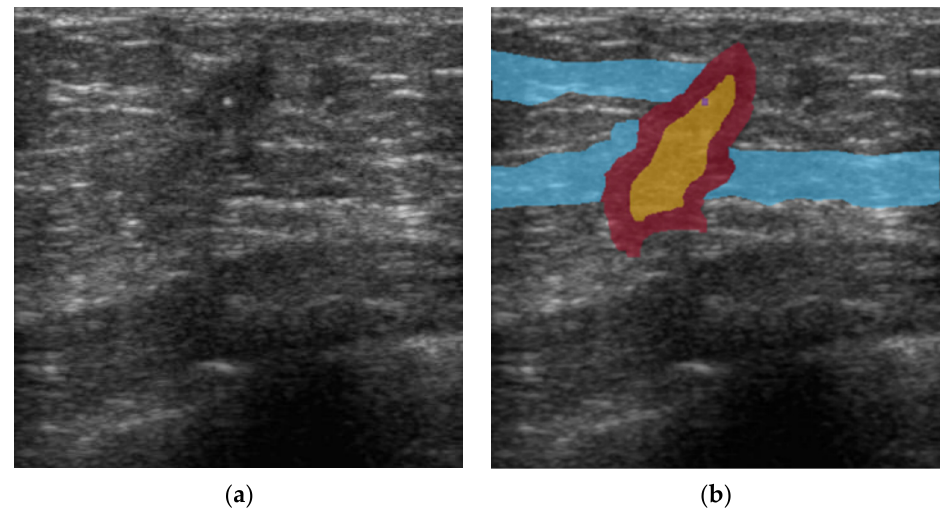
Figure 2. An example of an ultrasound image and ground truth image with corresponding Breast Imaging Reporting and Data System (BI-RADS) lexicon from a patient with malignant breast cancer. ( a ) sample image, ( b ) ground truth image, containing three BI-RADS lexicons: angular margin (red region), duct extension (light blue), and taller-than-wide (yellow).